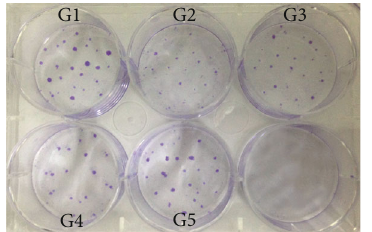
Figure 3: Colony formation of rGMSCs under in fl ammatory and anti-in fl ammatory environment. GIEMSA staining results for the colony-forming unit (CFU) assay (G1: GMSCs; G2: GMSCs+LPS; G3: GMSCs+LPS+10ng/mL IL-1ra; G4: GMSCs+LPS+100ng/mL IL-1ra; and G5: GMSCs+LPS+1 μ g/mL IL-1ra).